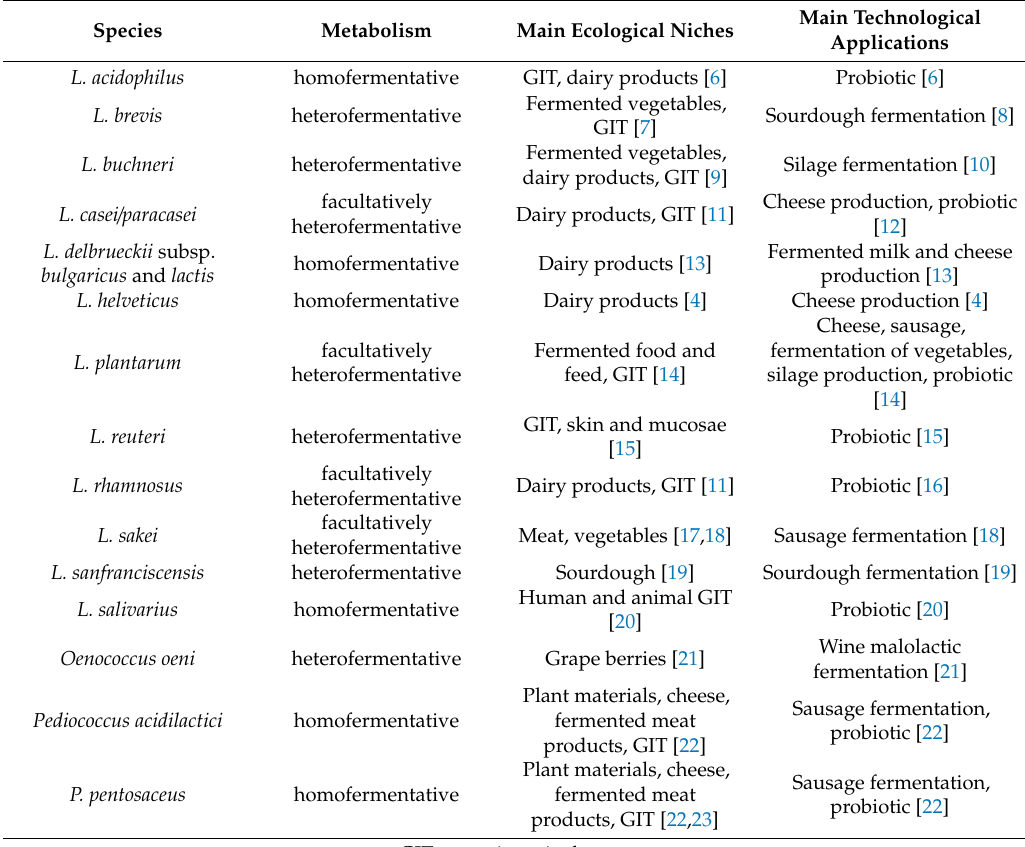
Table 1. Lactobacillus species most frequently used in food technology and as probiotics, type of metabolism, technological applications, and typical ecological